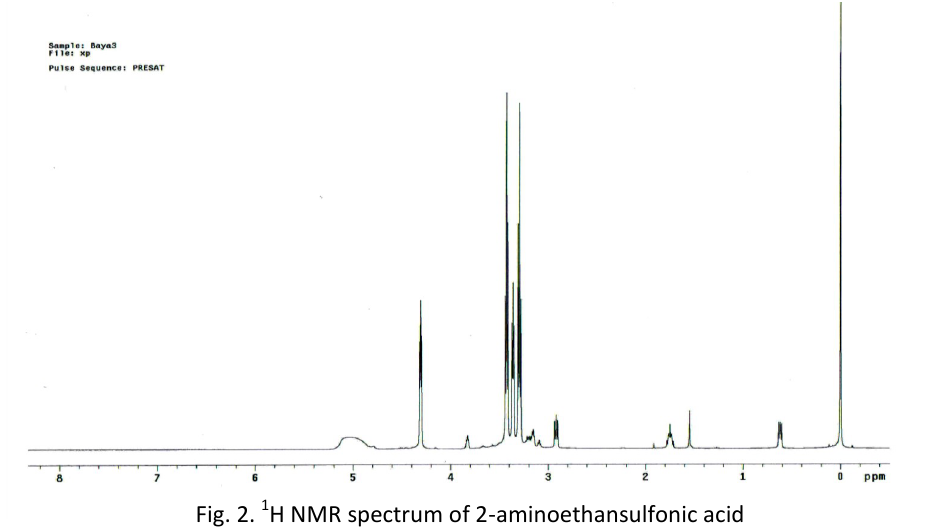
Fig. 2. 1 H NMR spectrum of 2-aminoethansulfonic acid